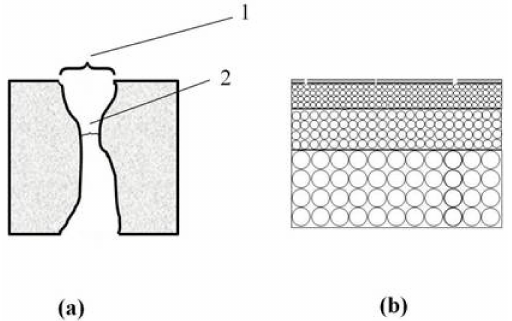
Figure 1. ( a ) Schematic of a pore tunnel. 1, pore mouth; 2, pore throat; ( b ) Schematic of dense membrane defects.